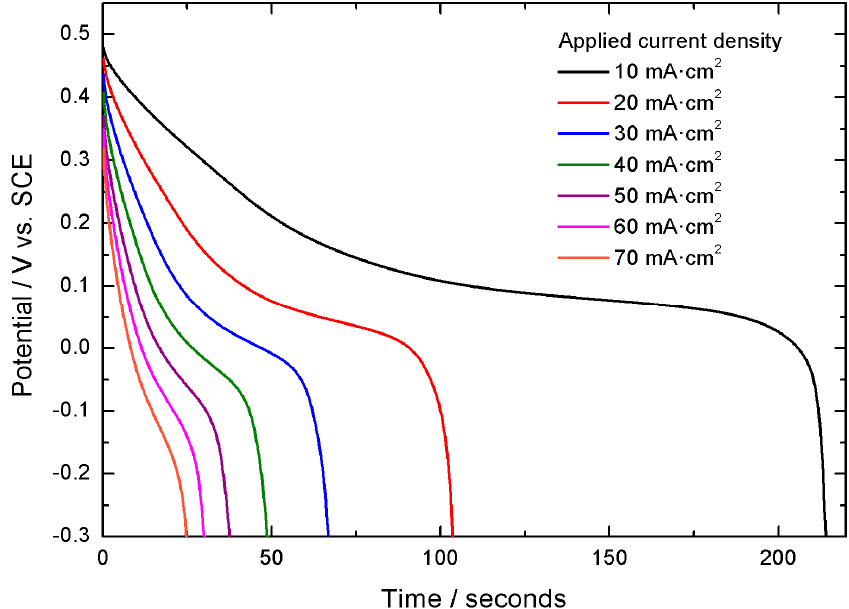
Figure 4. Galvanostatic discharge curves of nickel-cobalt hydroxide at different applied current densities.